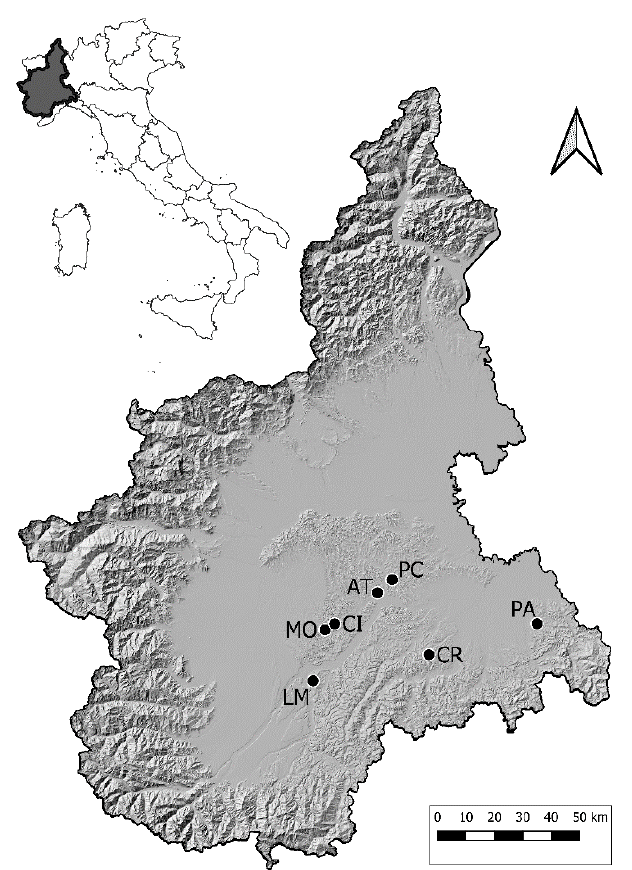
Figure 1. Location of the seven experimental sites within the Piedmont Region of Italy. AT, Asti; CI, Cisterna d’Asti; CR, Castel Rocchero; LM, La Morra; MO, Montà d’Alba; PA, Paderna; PC, Portacomaro.